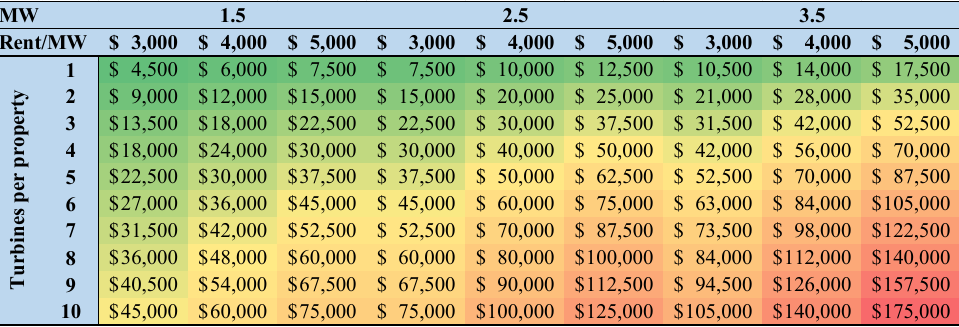
Table 3. Rental income per property considering the negotiated rental agreement (USD/MW), the NPC of the equipment and the number of installed wind turbines in the land plot.